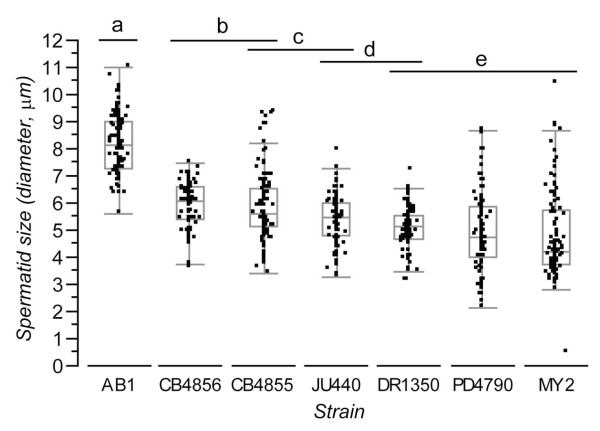
Size distributions of male spermatids for each of 7 strains (diameter, μm). Box-plots indicate median and inter-quartile range (points beyond whiskers are candidate outlier values). Horizontal bars at the top indicate Tukey HSD groups, with strains sharing identical letters not differing significantly.